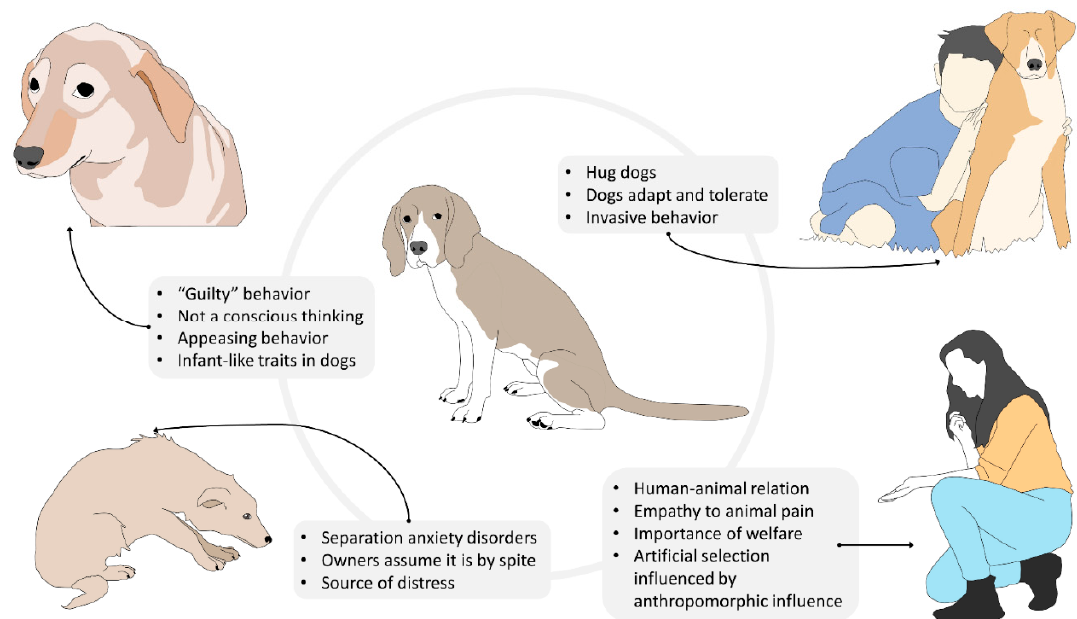
Figure 6. Influence of anthropomorphism on dog emotion, coping, and human–animal relations. The way humans interact and perceive animal emotions and behaviors can lead to misinterpretations of the motivation and intention of the animal, creating social consequences for them; however, when humans and their companion animal share a close bond, this can encourage empathy and the interest in their welfare.